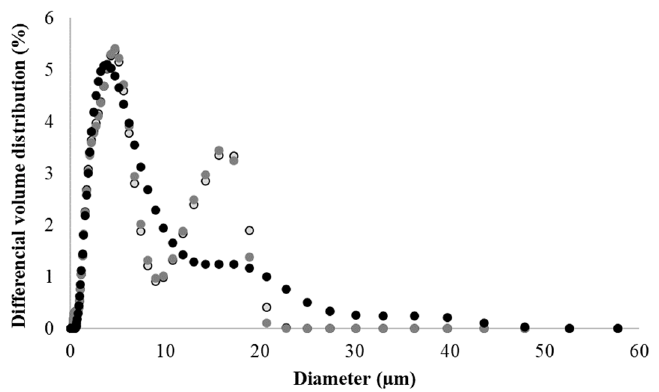
Figure 2. Particle size distribution of microparticles MpPE composed by the EC + PEG blend, considering differential volume distribution: replicate 1—grey circles with black line, replicate 2—dark grey circles and replicate 3—black circles.